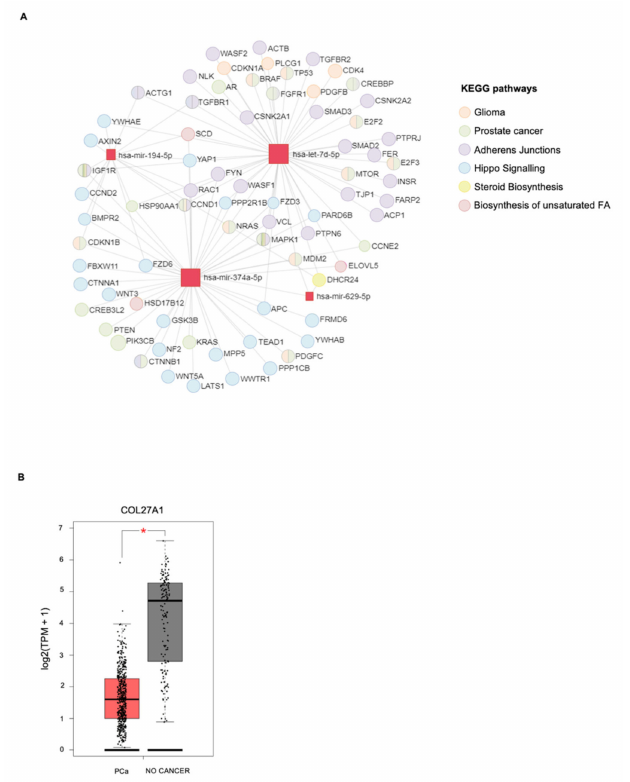
Figure 6. In silico analysis of miRNA–gene interactions. ( A ) Schematic representation of the miRNA– gene network resulting from the enrichment analysis of validated miRNA–gene interactions followed by targeted pathway analysis. A color code was used for grouping genes from the same KEGGS pathway. ( B ) Boxplots showing the mRNA expression of COL27A1 in tumor samples of PCa ( n = 492) from the PRAD-TCGA dataset and in normal tissues ( n = 152) from the TCGA and Genotype-Tissue Expression (GTEx) datasets. Expression analysis was performed and statistical significance was determined using the Gene Expression Profiling Interactive Analysis (GEPIA) web server. TPM, transcripts per million. A–B, * p -value <